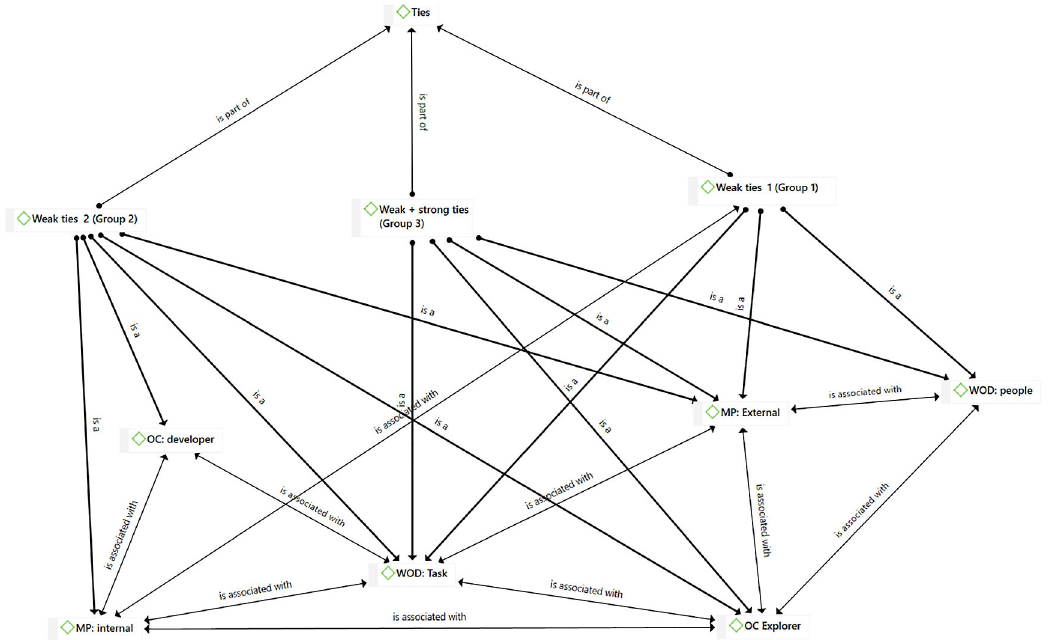
Figure 1. The network analysis from